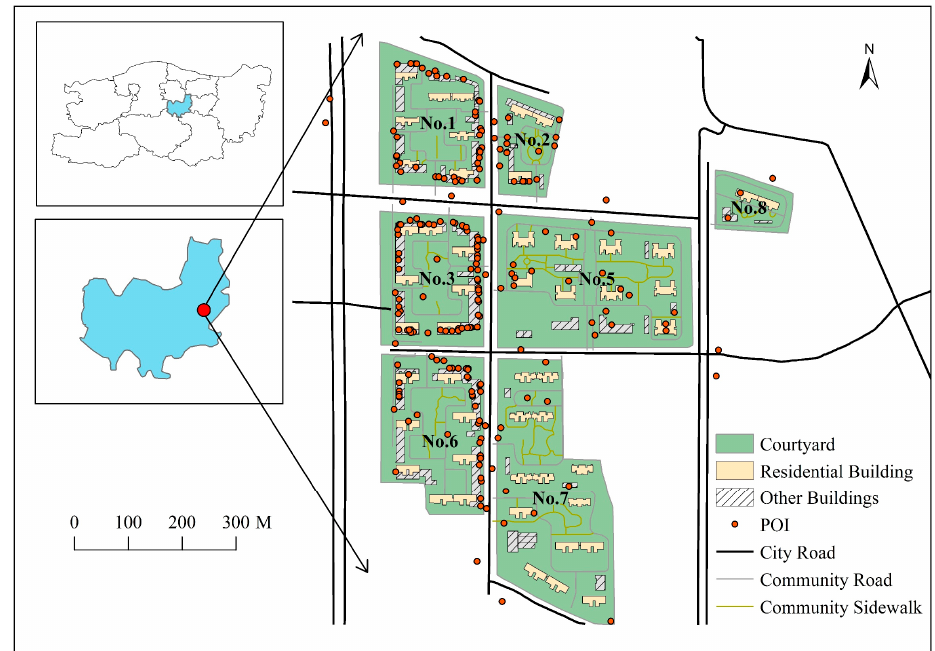
Figure 1. The spatial form and element distribution of the understudied area.